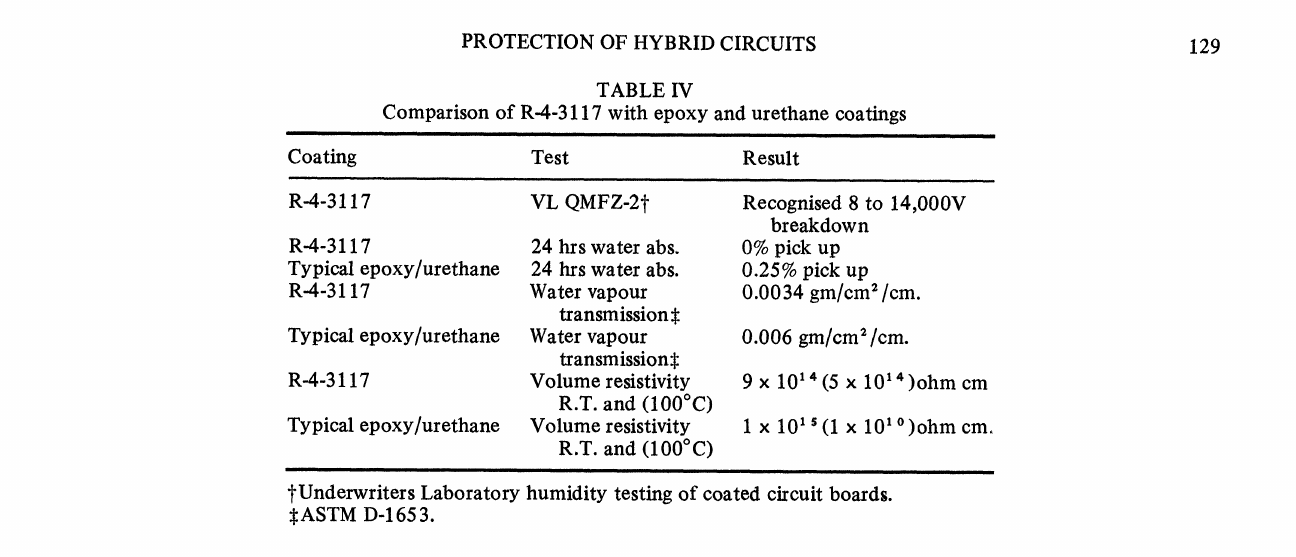
TABLE IV Comparison of R-4-3117 with epoxy and urethane coatings